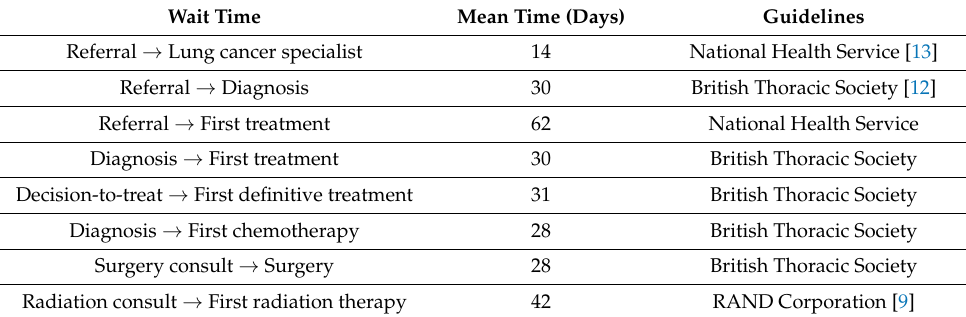
Table 1. Recommended wait times for lung cancer